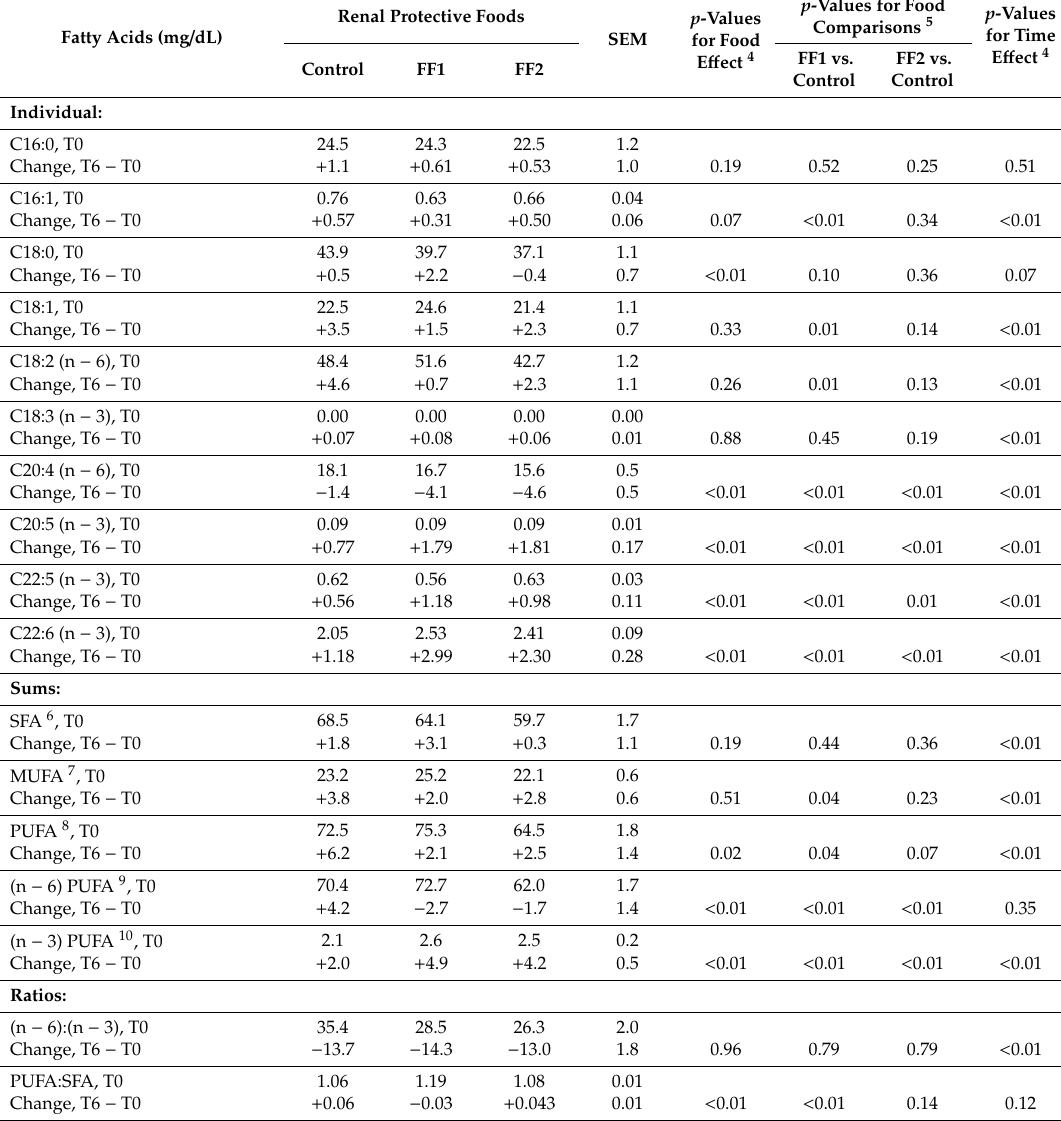
Table 5. E ff ect of feeding control 1 or one of two functional foods (FF1 and FF2) 2 for six months (T6) on serum concentrations of major fatty acids (FAs) in cats compared with their baseline values (T0) 3 . Fatty Acids (mg / dL)